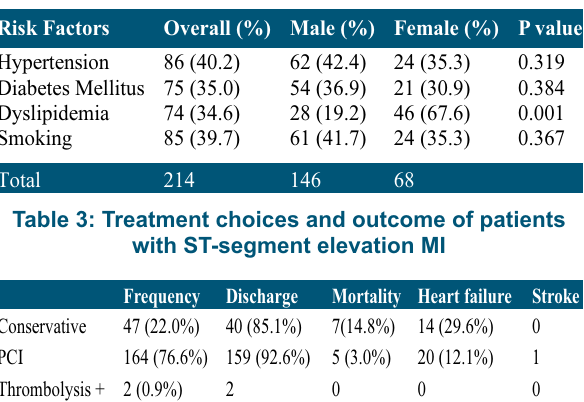
Table 2: Prevalence of risk factor among patients with ST segment elevation MI